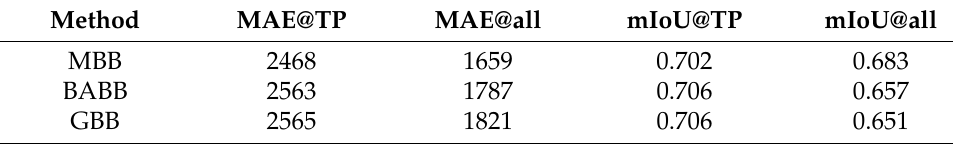
Table 5. GFA estimation evaluation metrics.